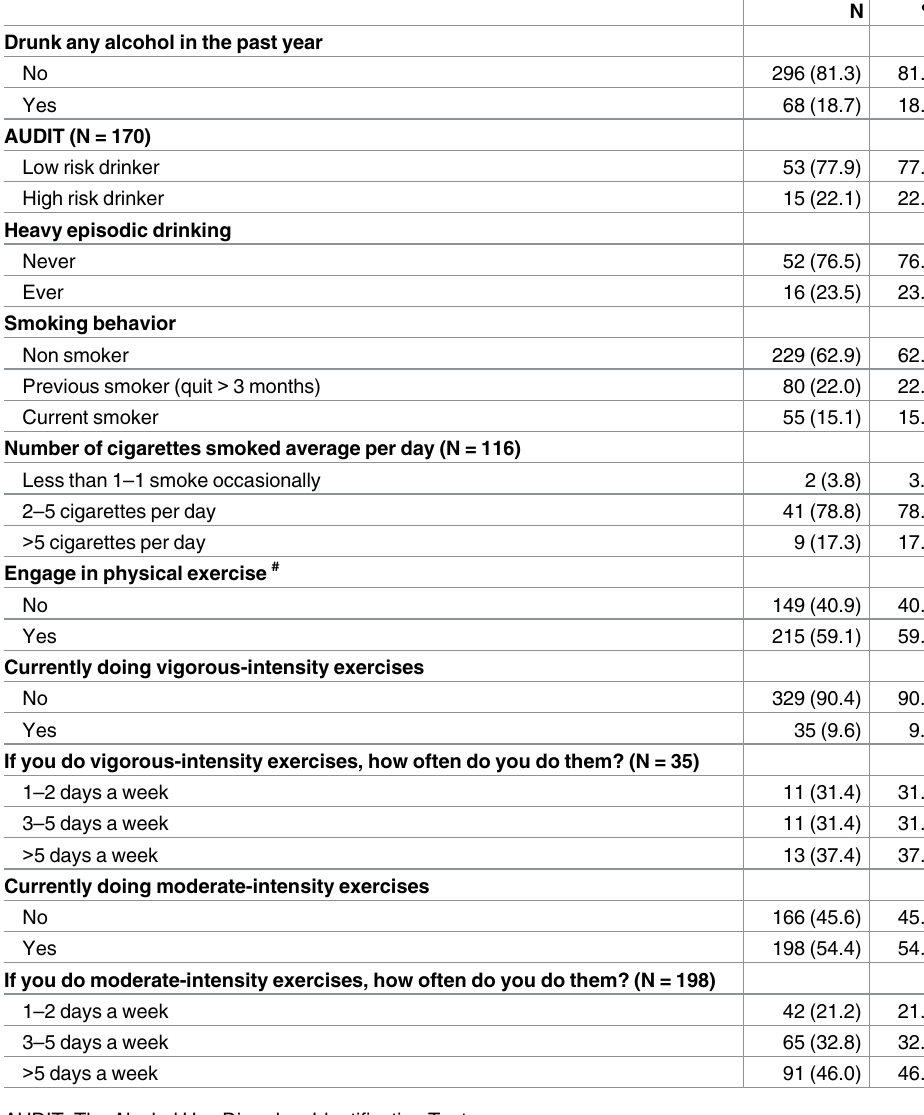
Table 2. Behavioral characteristics of HIV-infected older adults in Chiang Mai, Thailand.